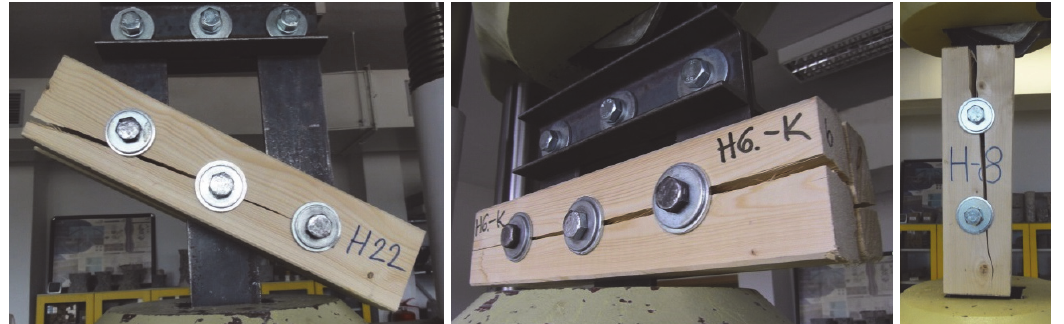
Figure 6: Damaged squared timber samples loaded in tension at different